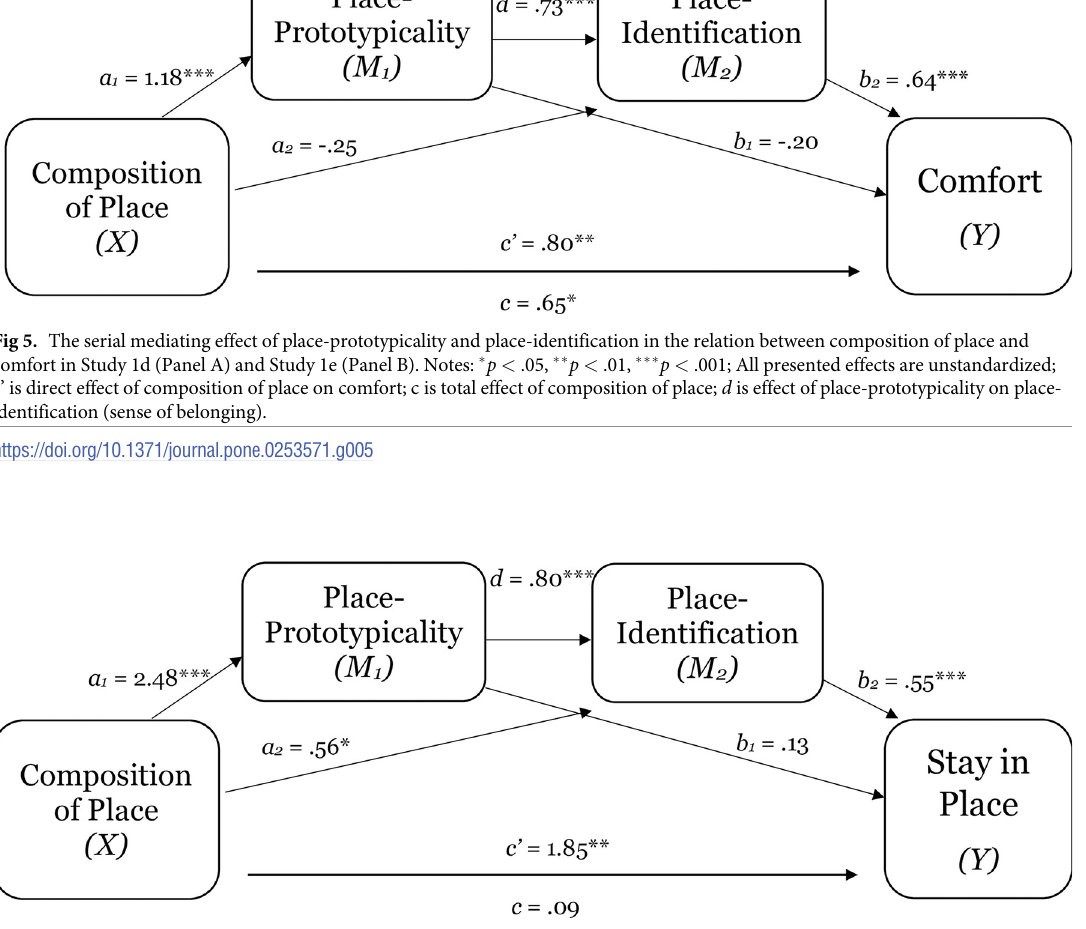
PLOS ONE | https://doi.org/10.1371/journal.pone.0253571 September 20,